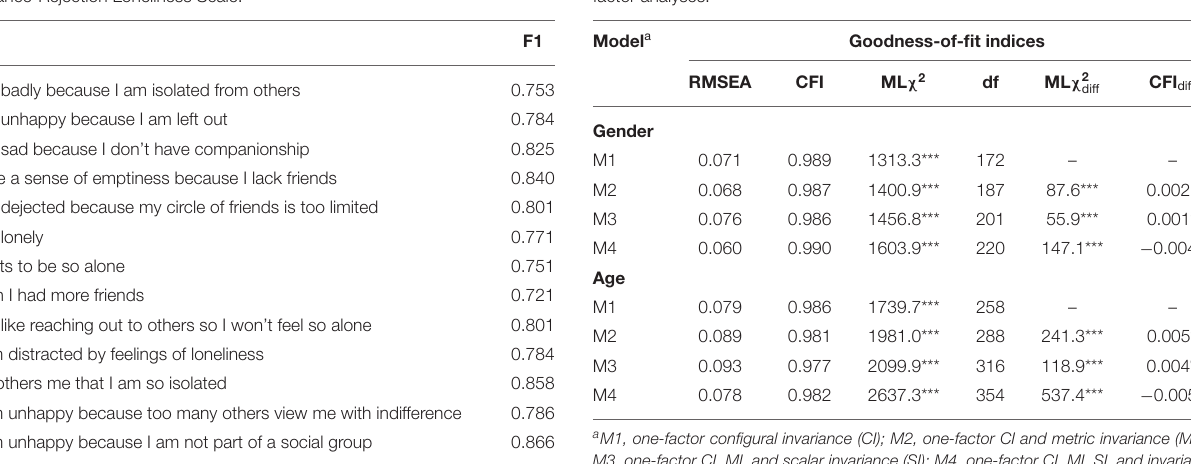
TABLE 2 | Measurement invariance analysis: multi-group hierarchical confirmatory factor analyses.